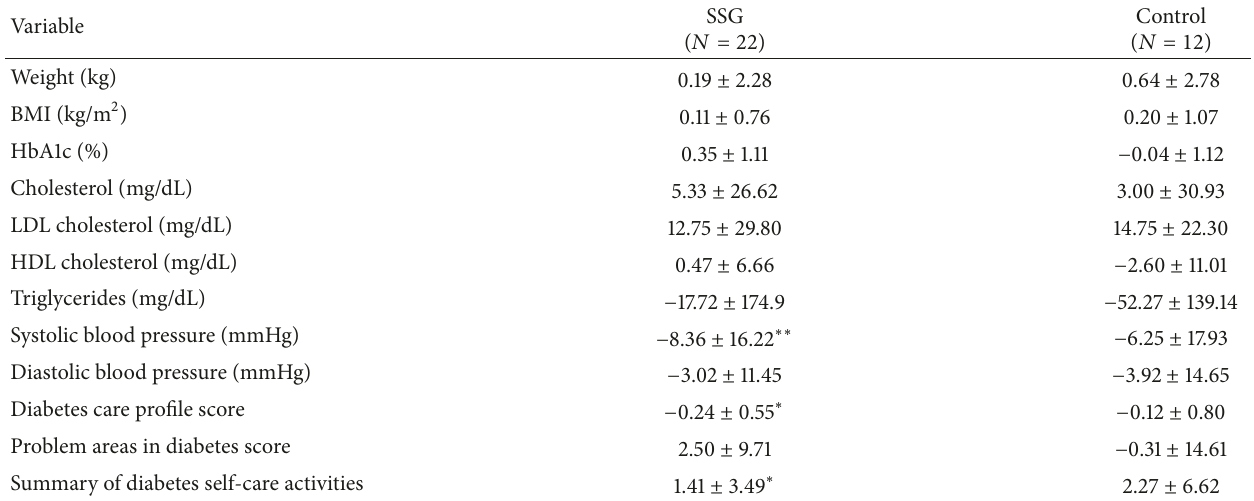
Table 3: Mean change in behavioral and biological measures from 𝑇 2 to 𝑇 3 by